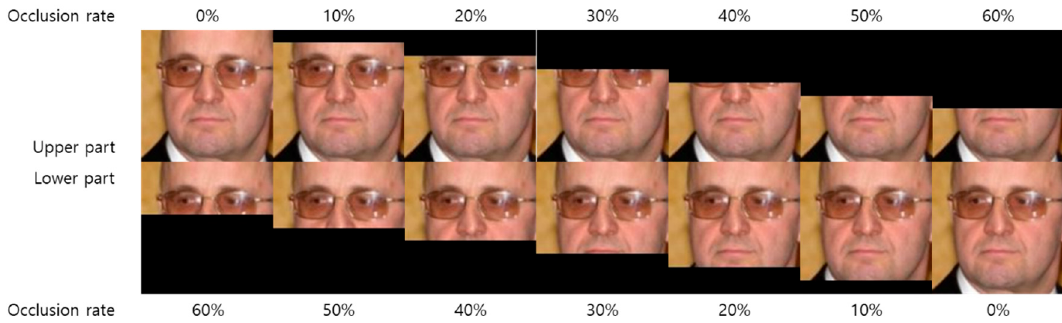
Figure 2. Example of occlusion images. The image is occluded in a certain proportion in up/down directions.